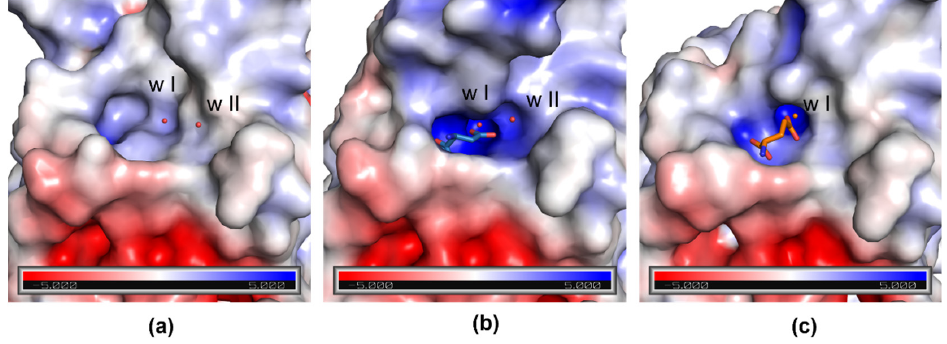
Figure 2. Electrostatic potential surface of apo ‐ N24S ( a ), N24S–ASP ( b ), and N24S–GLU (protomer D) ( c ) binding sites. Catalytic waters w I and w II are represented as red spheres, L ‐ ASP and L ‐ GLU as sticks. In N24S–ASP ( b ), part of the ASFL is not shown to make the binding pocket visible.